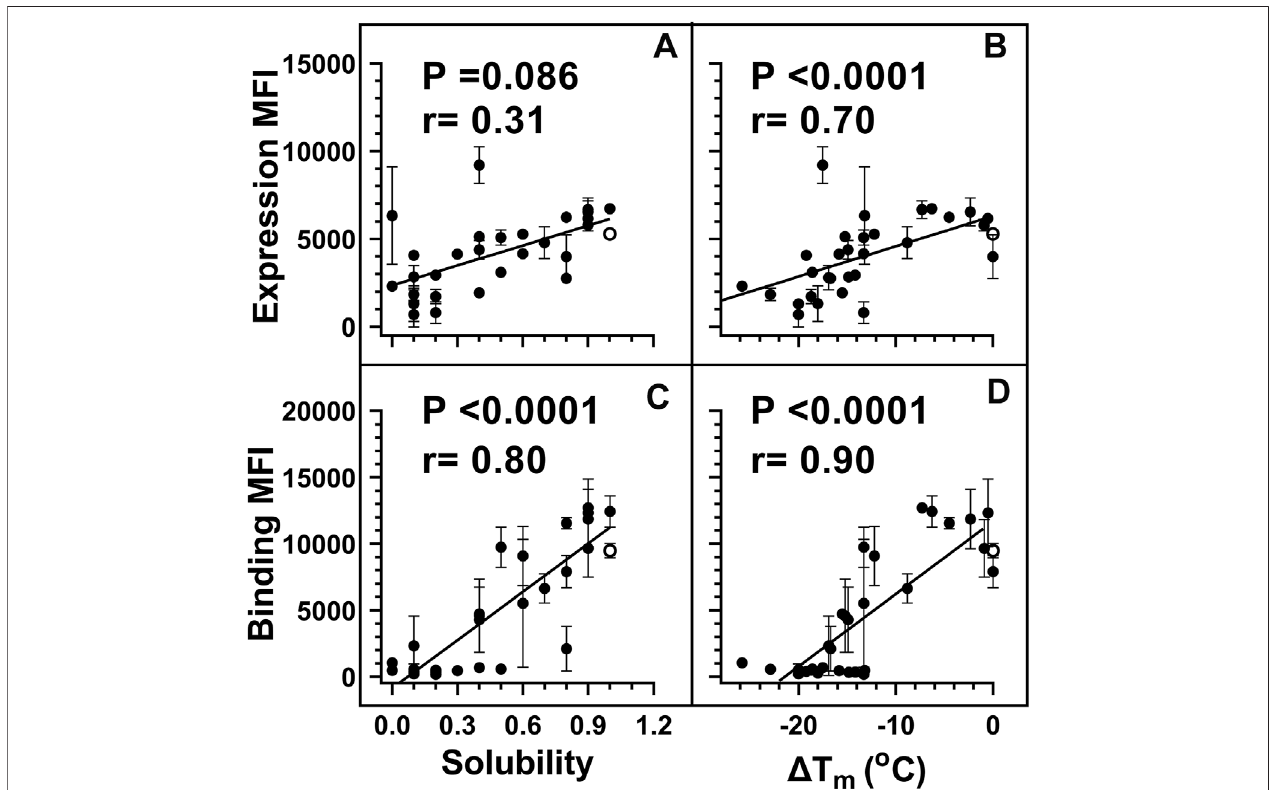
FIGURE 2 | Weighted correlations of E. coli in vivo solubility and in vitro thermal stability with the amount of total and active protein respectively, on the yeast cell surface. For individual mutants, MFI ’ s of expression and binding were estimated by probing the HA tag on surface expressed protein and the FLAG tag on cell surface bound GyrA14 respectively. For weighted correlation calculation, a weight of 1/( σ /µ) was used. Here σ and µ represent the standard deviation and mean values for each point respectively.Weighted correlation of the total amount ofprotein (Expression MFI) displayed on the yeast cell surface with (A) in vivo solubility and (B) Δ T m [T m (mutant)-T m (WT)] of CcdB mutants. Weighted correlation of the amount of active protein (Binding MFI) on the yeast cell surface with (C) E. coli in vivo solubility and (D) Δ T m ofCcdB mutants. Abettercorrelationwasobservedbetweenbiophysicalparameters withbindingMFIrather thanexpression MFI. Inthe increasedby1 ° Ctoremoveoverlapwithanotherpoint.Datafor E.coliinvivo solubilityandthermalstabilitywastakenfromTripathietal.(Tripathietal.,2016).WTdatais shown in open circles. p values indicate the signi fi cance for non-zero slope values in all the